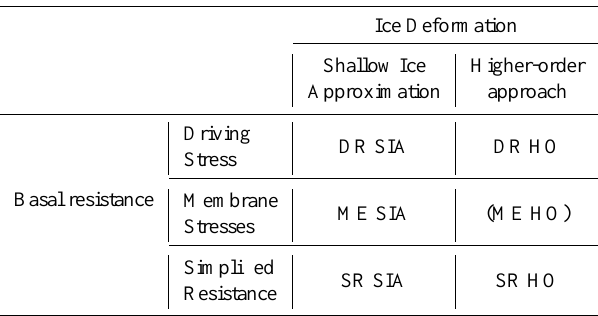
Table 2. Overview of model versions with different approaches to describe ice deformation and basal resistance. Note that the ME HO combination is omitted in this work. Details to each approach are described in Sect. 2.3 and in Appendix B.